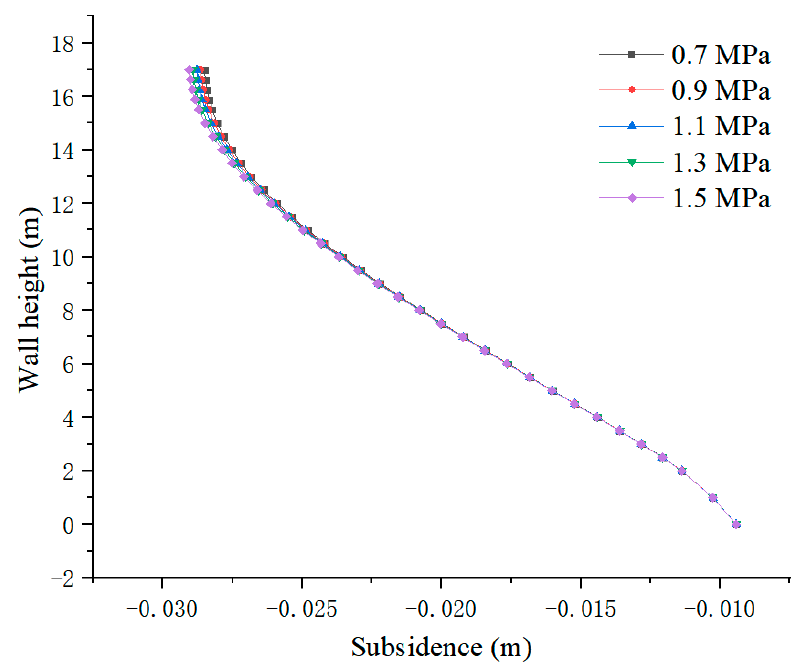
Figure 8. Distribution of subsidence along the anti-seepage wall under the action of different load amplitudes.